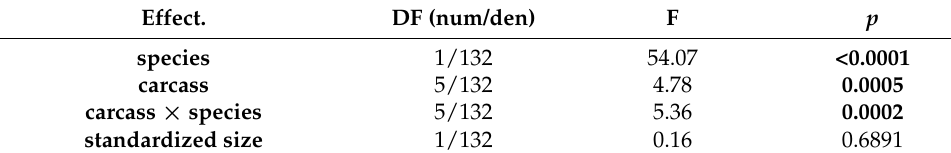
Table 1. Results of ANCOVA for lifetime number of offspring. Significant effects are bolded. Effect.